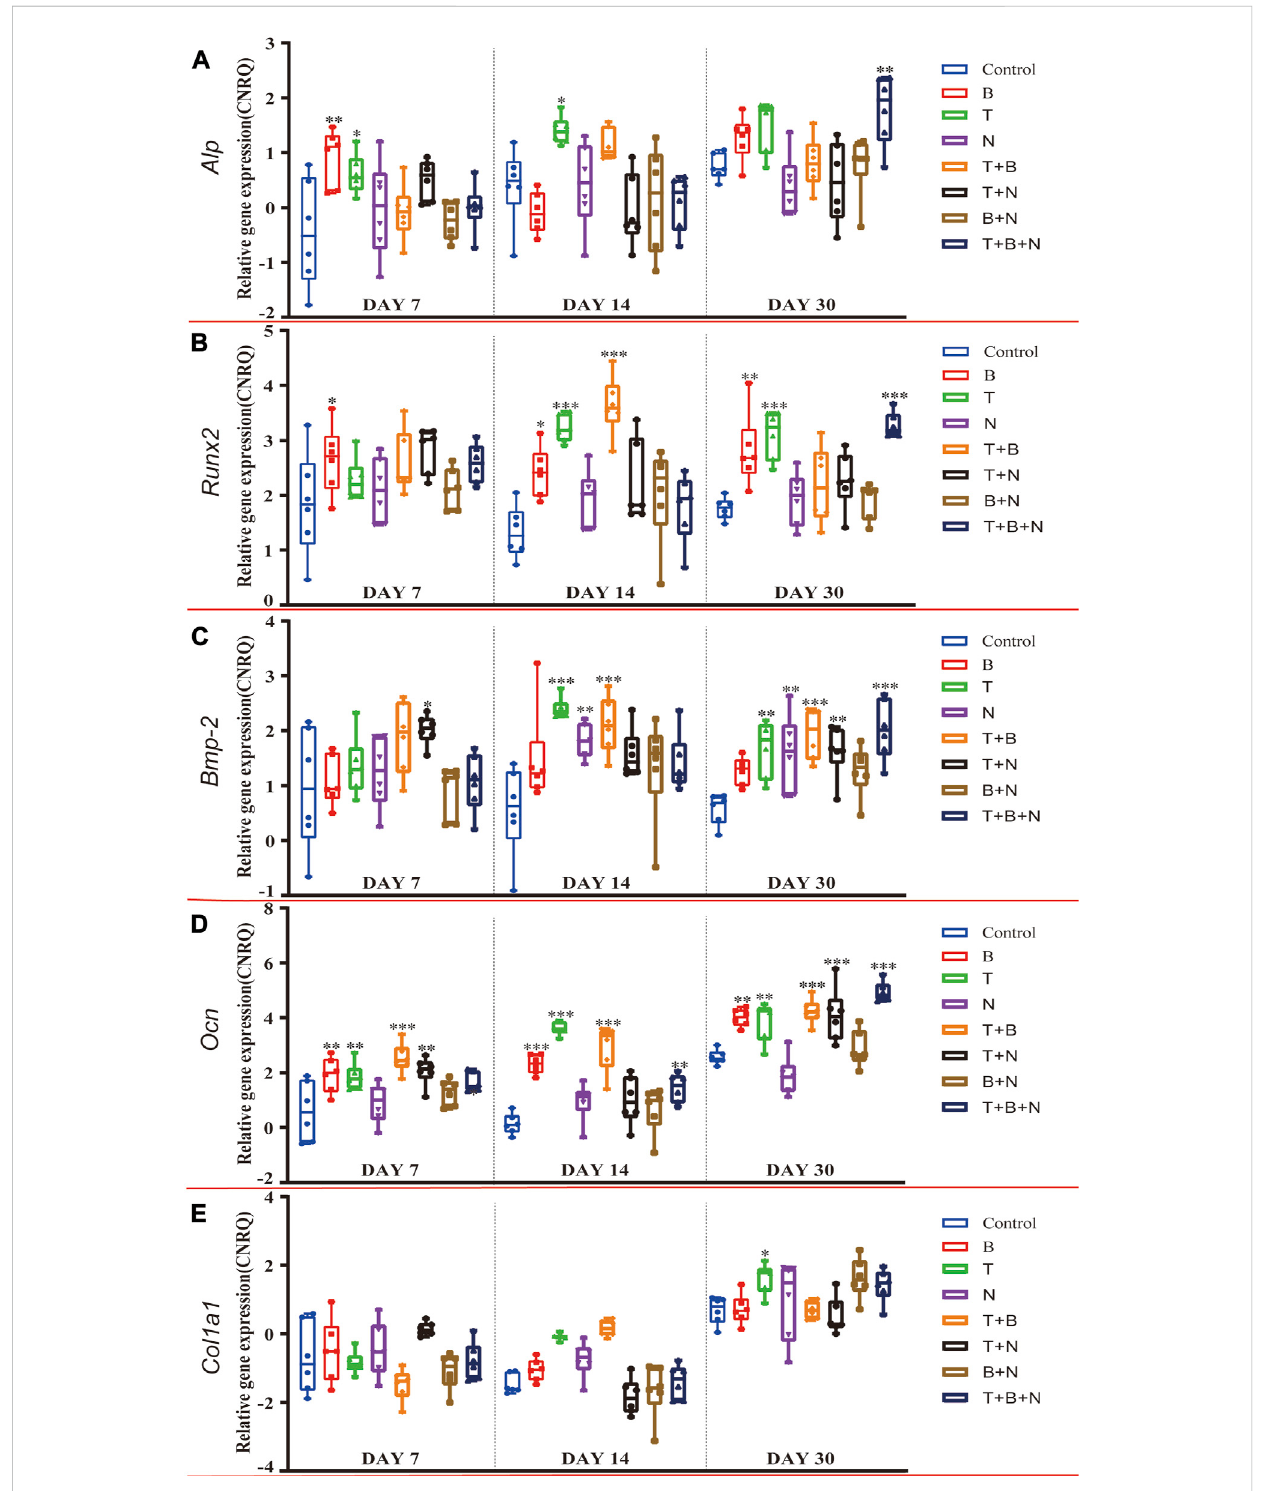
FIGURE 4 Therelativegeneexpressionof (A) Alp, (B) Runx2 , (C) Bmp-2 , (D) Ocn ,and (E) Col1a1 at7,14,and30 days,whichwereshownasCNRQ.Theasterisks indicate that the stimulated group is statistically signi fi cant compared to the control group. The baseline number 0 indicates non-cultured fresh tissue was used as the normalization parameter. (n = 6; * p < 0.05; ** p < 0.01; *** p <